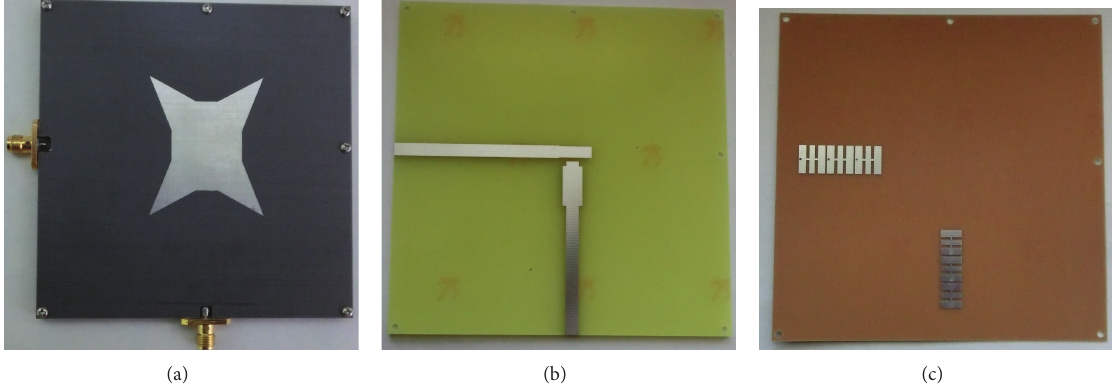
Figure 5: Photograph of the proposed antenna. (a) Top view of the antenna, (b) top view of the feed line, and (c) top view of the DEP-EBG.